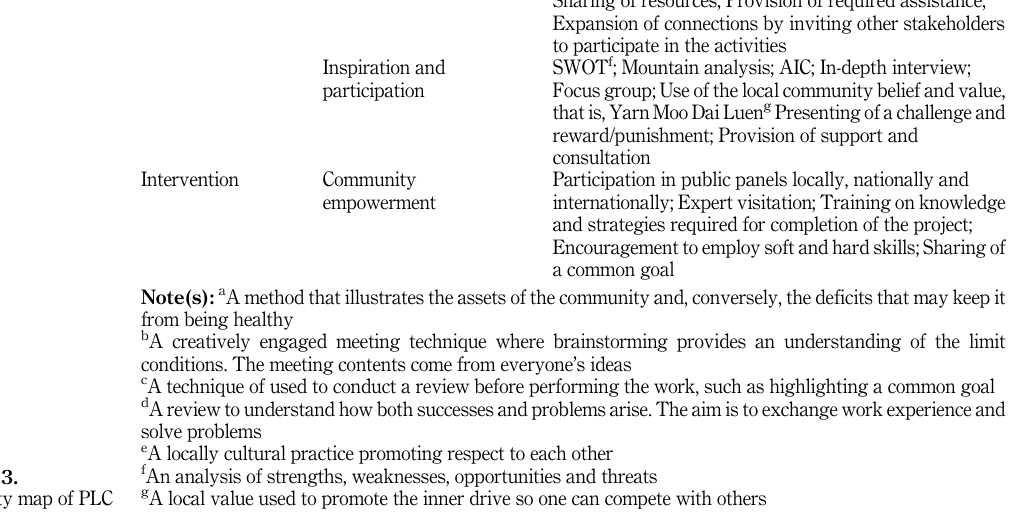
Table 3. Capacity map of